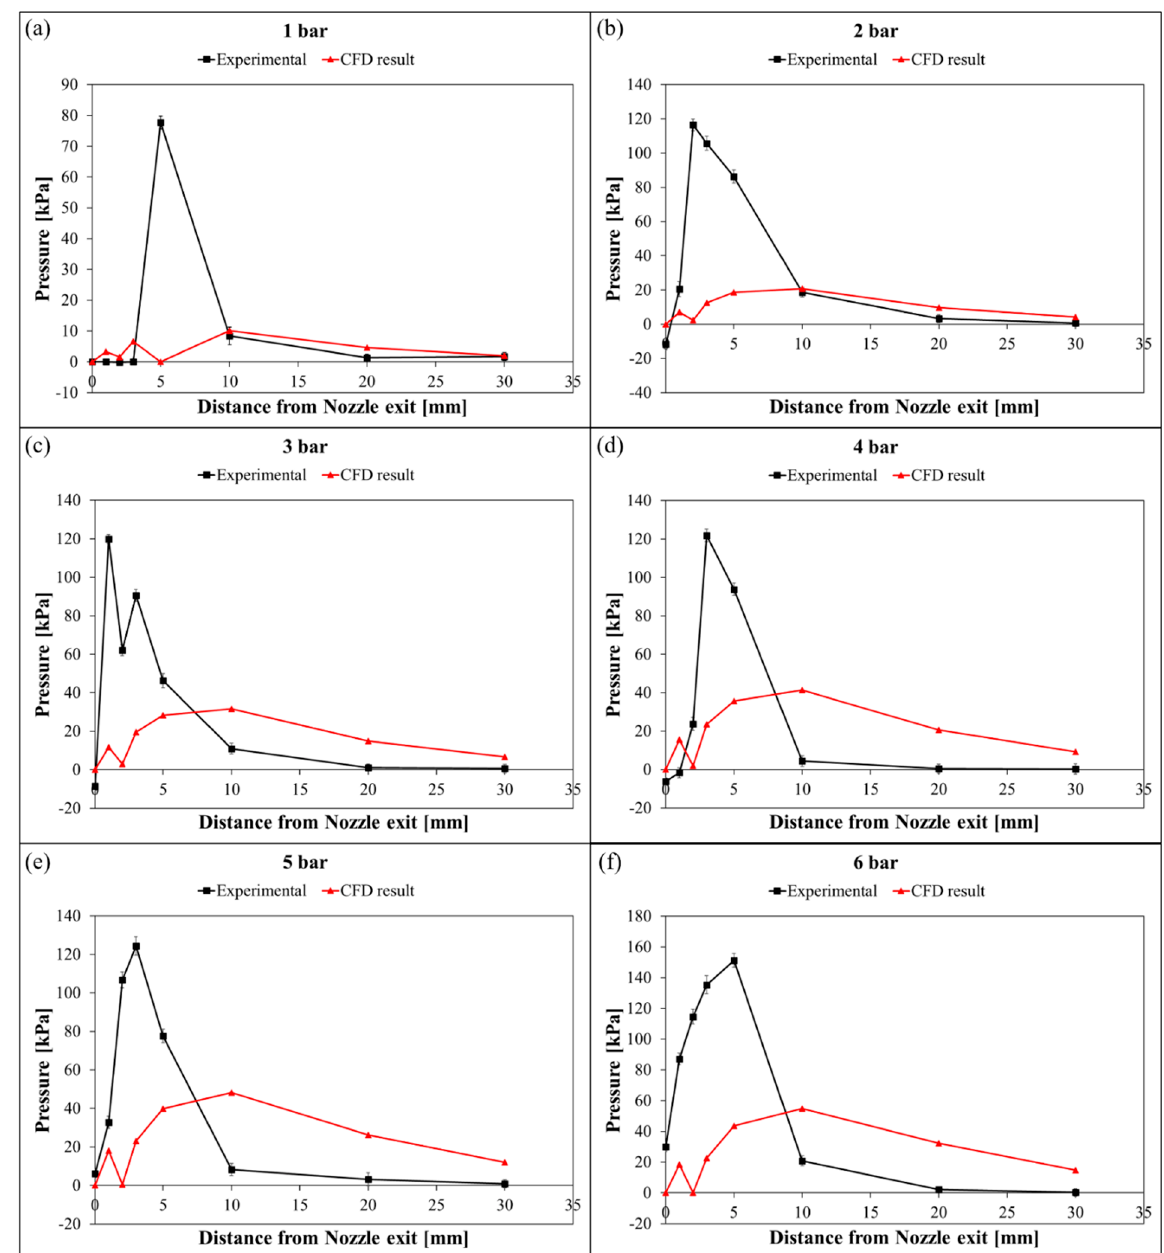
Figure 4. Comparison between CFD and experimental results for output air pressure at different input pressure values: ( a ) 1 bar, ( b ) 2 bar, ( c ) 3 bar, ( d ) 4 bar, ( e ) 5 bar, and ( f ) 6 bar.